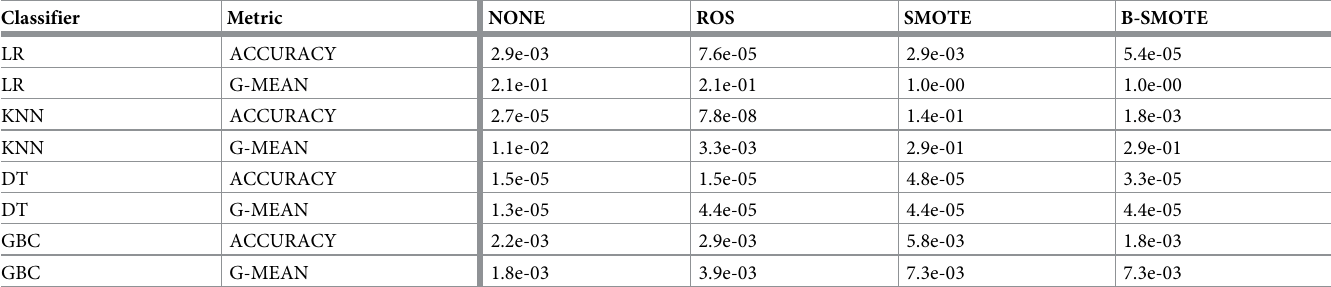
Table 6. The p-values of the Holm’s